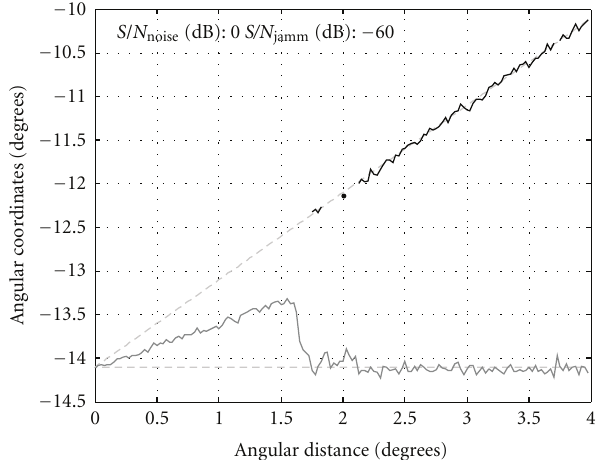
Figure 14: Histogram of polar coordinates evaluated by means of the TLS ESPRIT method at S/N noise = 0dB, S/N jamm = − 60 dB and without initial preprocessing.